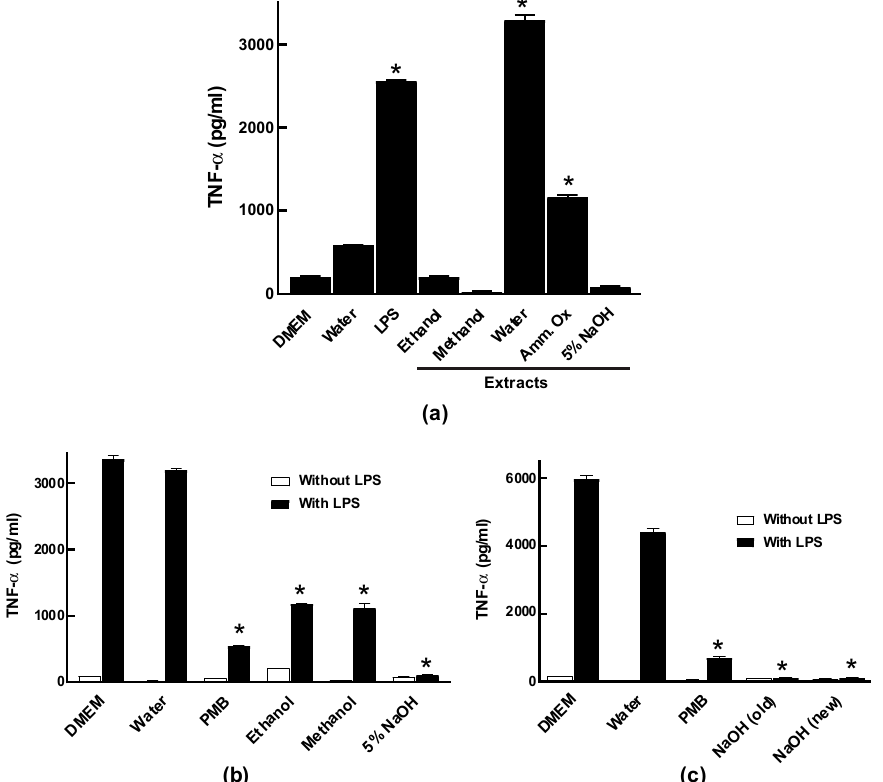
Figure 1. Immuno-modulatory activities of crude extracts obtained from Echinodontium tinctorium. ( a ) At 1 mg/mL, crude extracts (80% ethanol, 50% methanol, water, 2% ammonium oxalate, and 5% NaOH) were assessed for their ability to induce TNF- α production in RAW264.7 macrophage cells as an indicator of immuno-stimulation. Lipopolysaccharide (LPS) was used as positive control, whereas media and water were used as negative controls. ( b ) Crude extracts (1 mg/mL) that were inactive for immuno-stimulation (80% ethanol, 50% methanol, and 5% NaOH) were tested for their ability to inhibit LPS-induced TNF- α production as an indicator of anti-inflammatory activity. Polymyxin B (PMB; an inhibitor of LPS) was used as a positive control, whereas media and water treated with LPS were used as negative controls. ( c ) Comparison of the anti-inflammatory activity of 5% NaOH extract from two different collections of E. tinctorium. Due to the large quantity of a new collection, the new NaOH